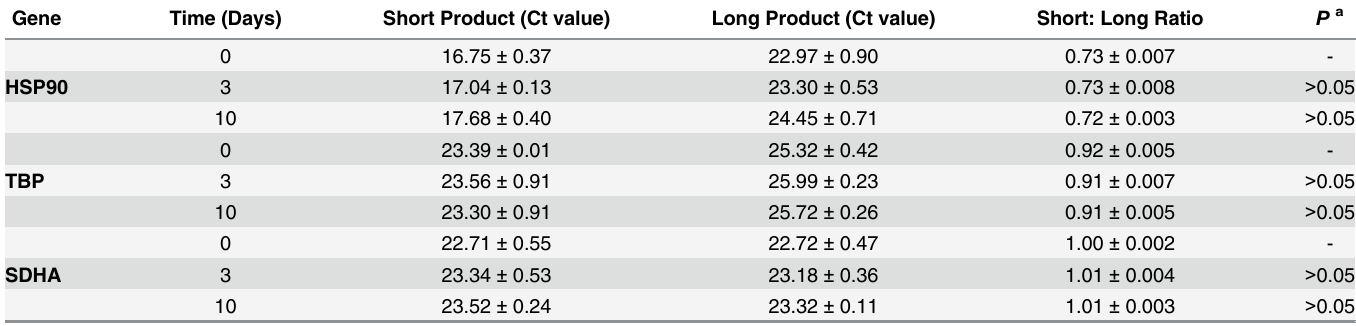
Table 3. Assessment of RNA integrity by the relative abundance of short and long qPCR products of three stable reference genes over differing storage times in pierced Varroa in RNA-Later at room temperature. Gene